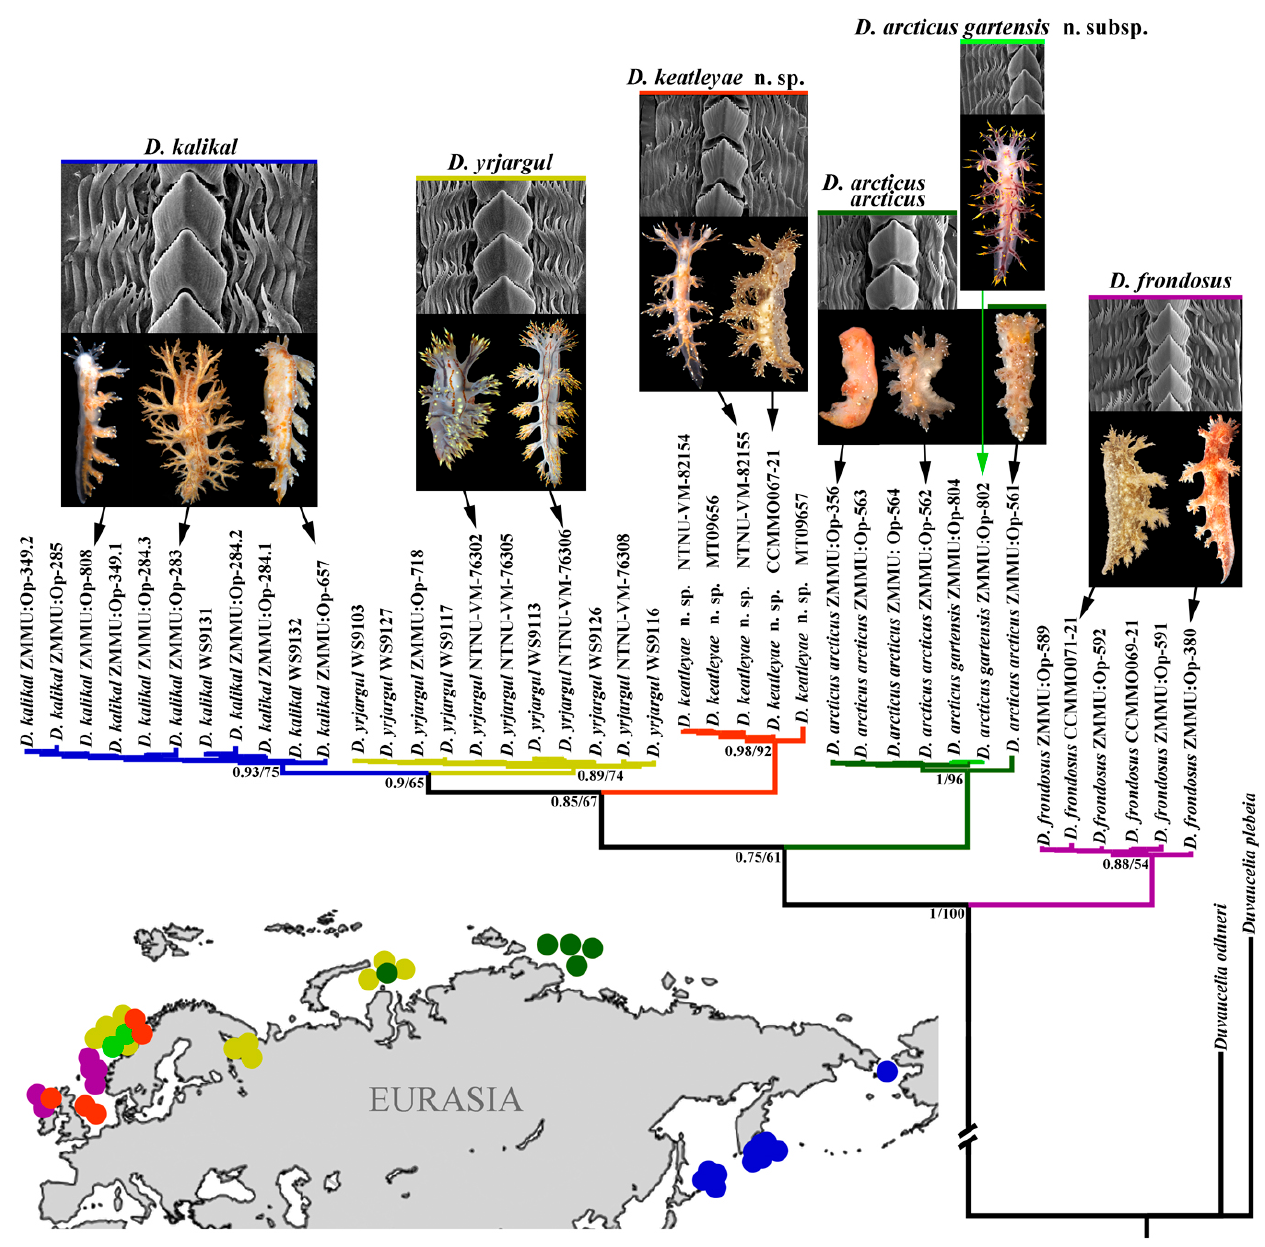
Figure 6. Phylogenetic tree based on concatenated molecular data (cytochrome c oxidase subunit I + 16S) represented by Bayesian inference (BI). Numbers represent posterior probabilities from BI and bootstrap values for maximum likelihood. For each species, colour pattern examples and single low variable radular characteristics are presented. Map showing the distribution of Dendronotus species, used for molecular phylogenetic analysis.